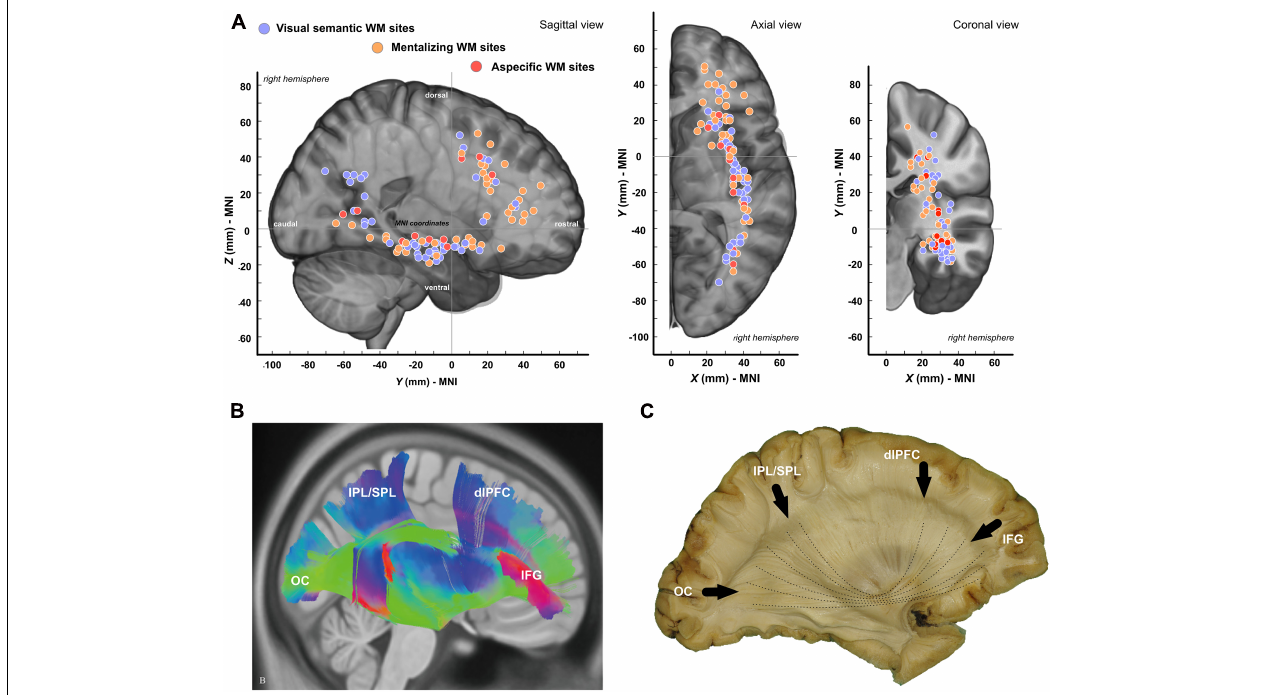
FIGURE 3 | Spatial distribution of white matter sites. (A) Tridimensional distribution of WM sites. (B) Template-based fiber tracking of the right IFOF with q-diffusion imaging (from Wu et al., 2016). (C) Anatomical dissection of the right IFOF (personal materials). OC, occipital pole; IPL, inferior parietal lobule; SPL, superior parietal lobule; dlPFC, dorsolateral prefrontal Cortex; IFG, inferior frontal